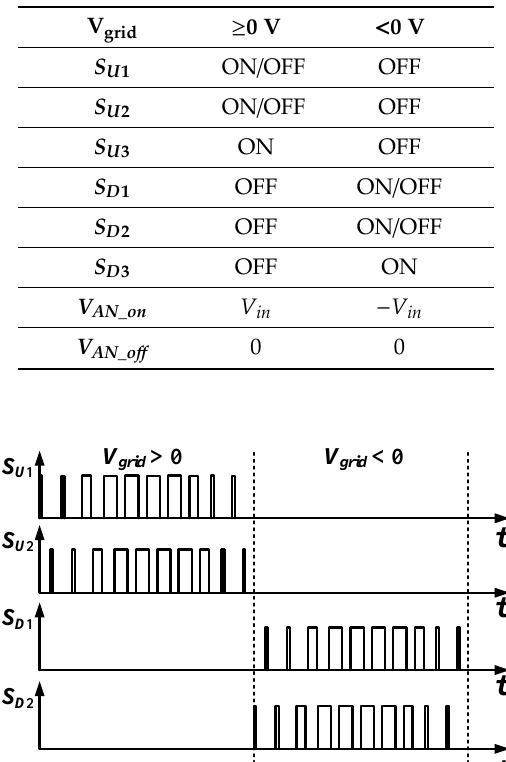
Table 1. Switching states and input voltages for inductors in the proposed inverter.